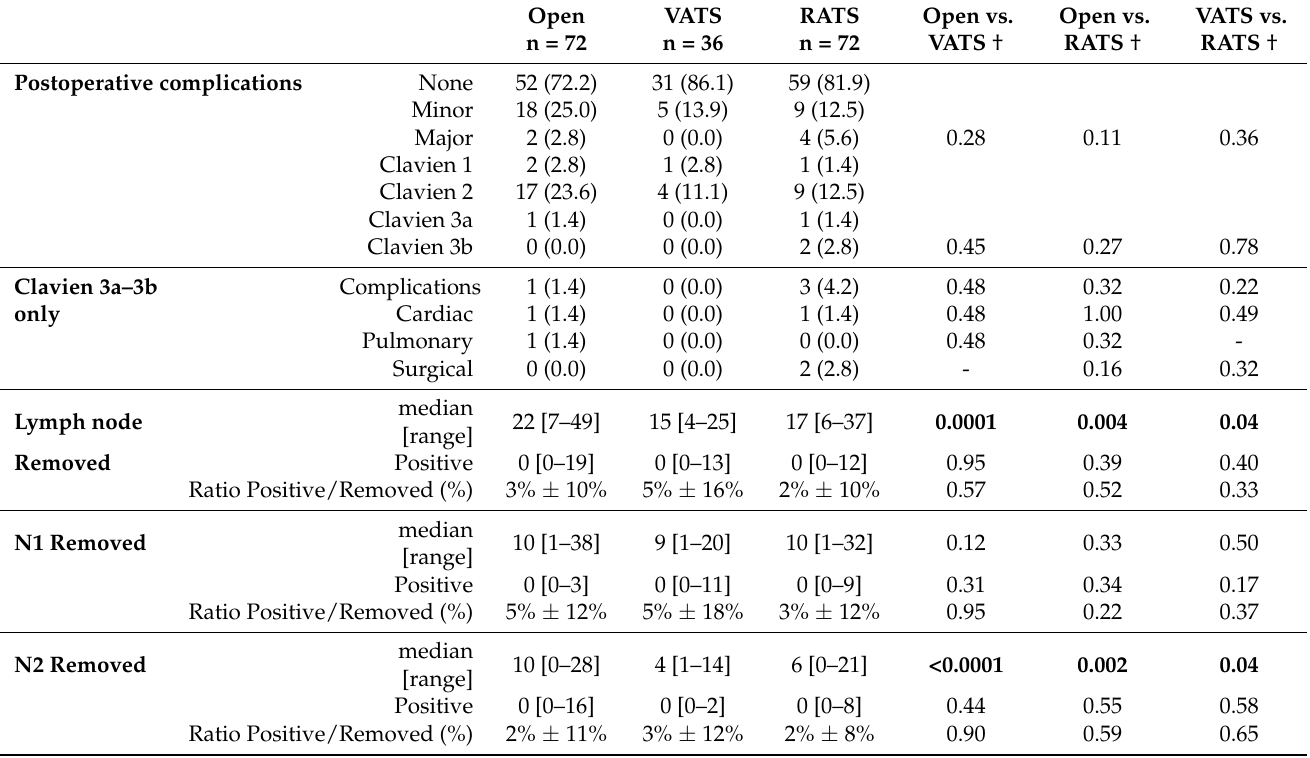
Table 2. Patients’